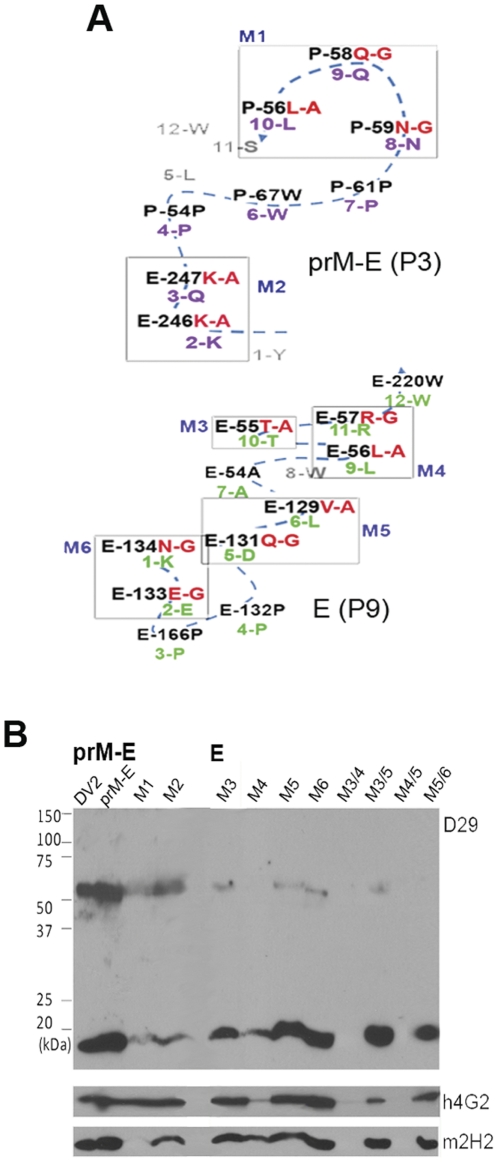
Site-directed mutagenesis of predicted epitope on prM-E protein.(A) To confirm the binding epitope of D29 Fab-IgG, residues within the P3 and P9 predicted sequences were mutated to generate mutants 1–6 (M1-6); M3/4, M3/5, M4/5 and M5/6 contain combinational-mutations as stated. (B) Reactivity of antibodies with the mutants was tested by Western blot analysis. Cleared lysate of DENV2-infected Vero cells (DV2), pCMV-prM-E- (prM-E) or mutants-transfected HEK 293 T cells (M1-5/6) were separated on 12% SDS-PAGE in non-reducing condition, followed by detection with h4G2, m2H2 and D29 Fab-IgG.